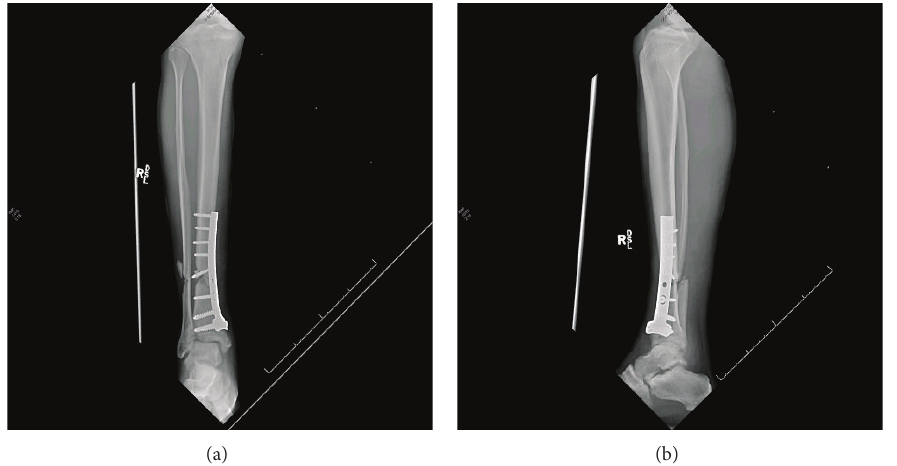
Figure 2: ((a) and (b)) Radiographs of an atrophic nonunion of the tibia with hardware failure one year after motorcycle collision resulting in an open tibial fracture. In this patient, little or no callus is